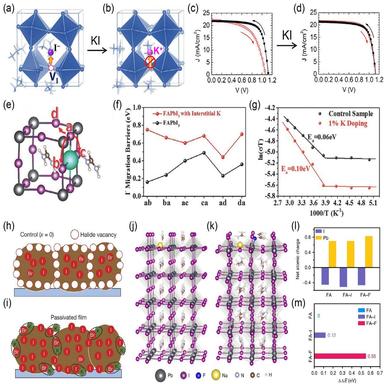
(a and b) Potassium ions occupy the interstitial site and prevent the formation of Frenkel defect. J-V curves of PSCs without (c) and with (d) KI. Copyright 2018, American Chemical Society. (e) Illustration of I diffusion pathways in FAPbI3 perovskite with K+ at an interstitial site. (f) Comparison of I diffusion barriers in FAPbI3 with and without interstitial K+ . (g) Temperature-dependent conductivity measurement of Cs/MA/FA perovskite without and with 1% K doping. Copyright